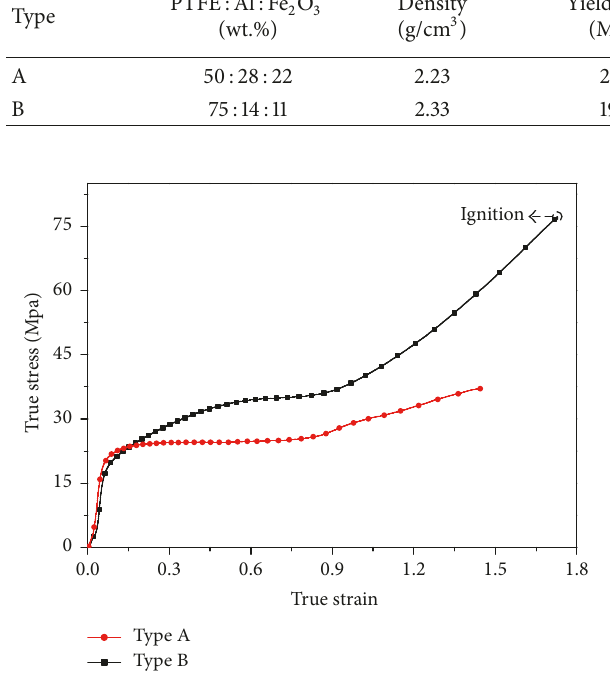
Figure 4: Stress-strain curves of two kinds of PTFE/Al/Fe 2 O 3